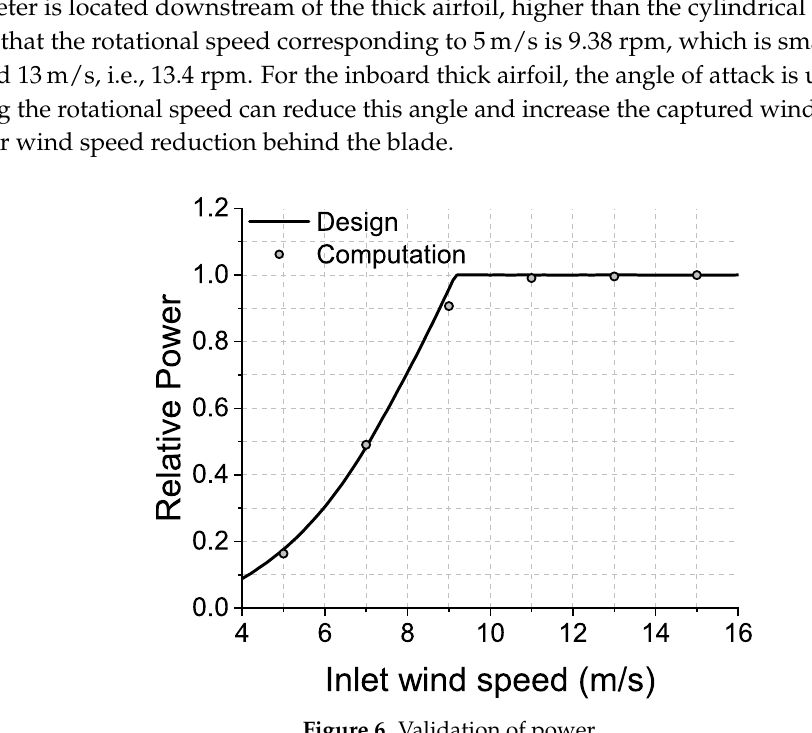
Figure 6. Validation of power. Table 3. Variation of V N with stable inlet flow